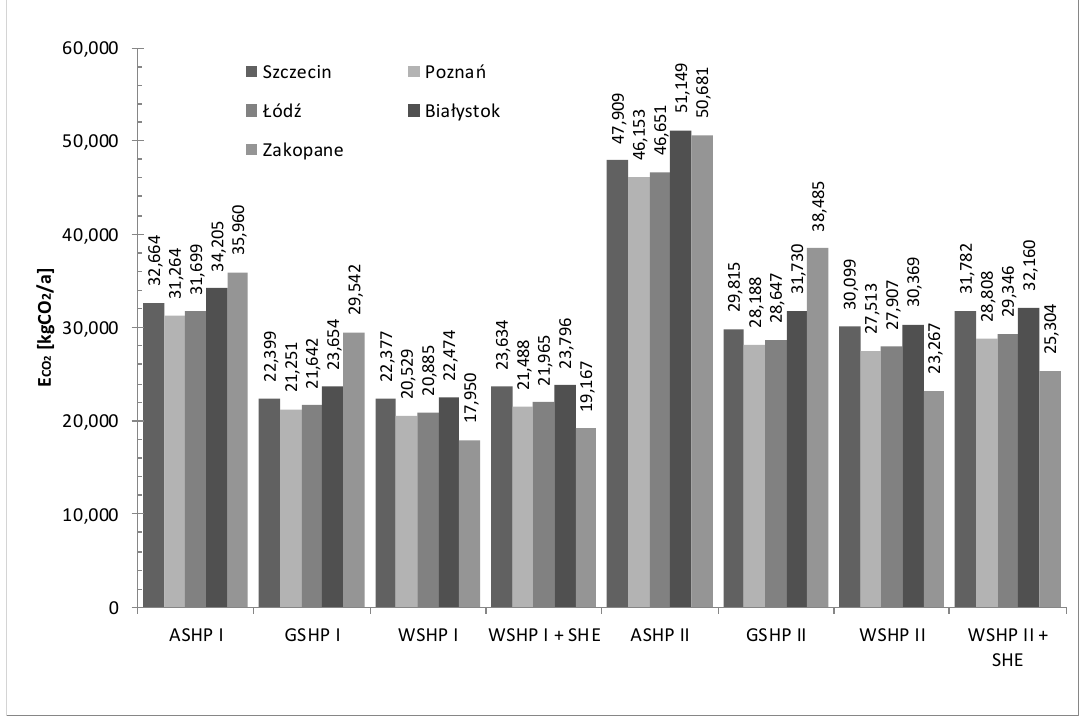
Figure 6. Indirect emissions of carbon dioxide values for specific locations in the variants I and II.